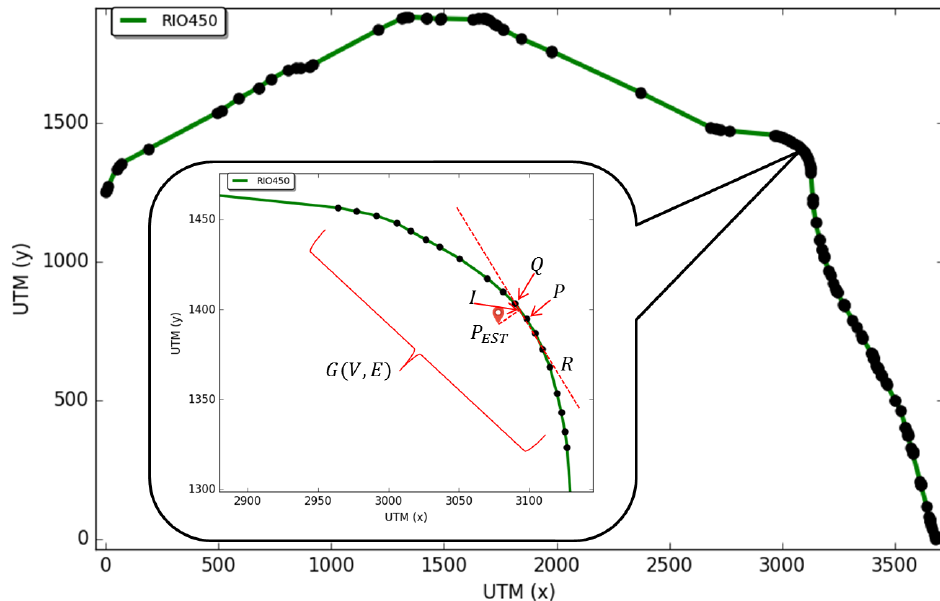
Figure 6. Map adjustment using road